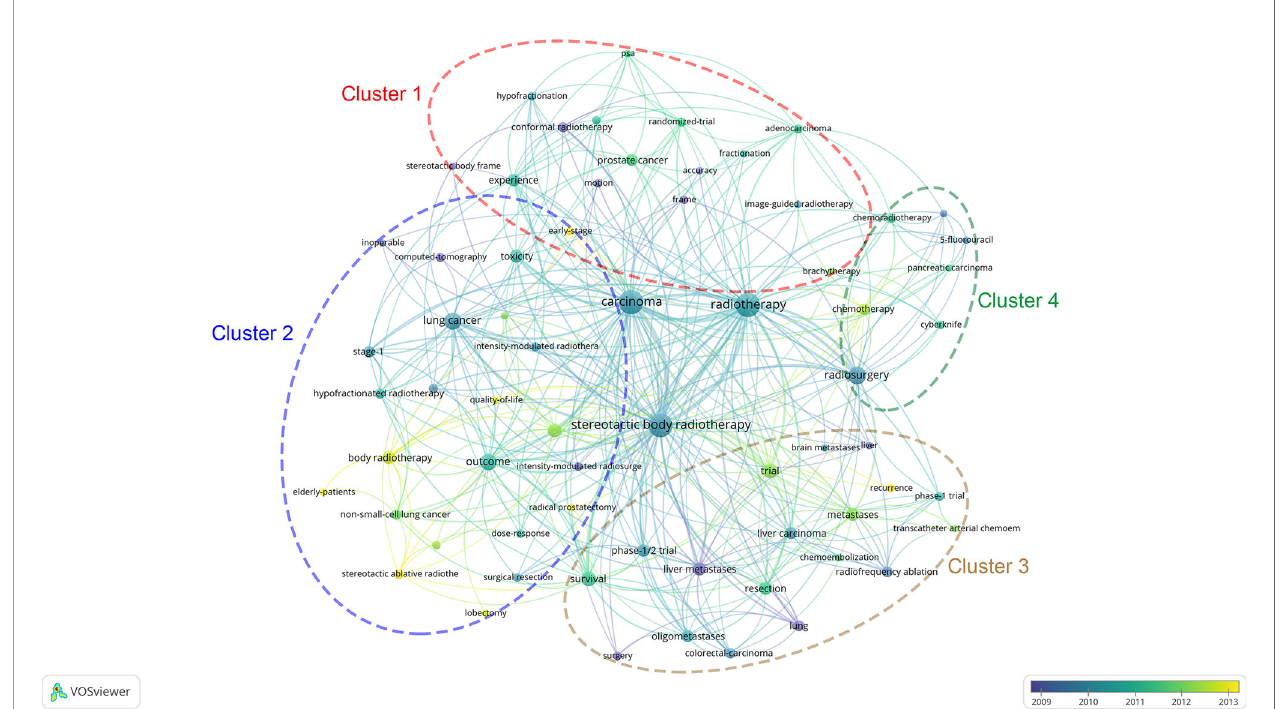
FIGURE 6 | The network visualization of keywords from the 100 most cited articles according to the average published year. The circle size represents the number of articles in the 100 most cited articles. The width of the curved line represents the link strength. The distance between 2 keywords approximately indicates the relatedness of the